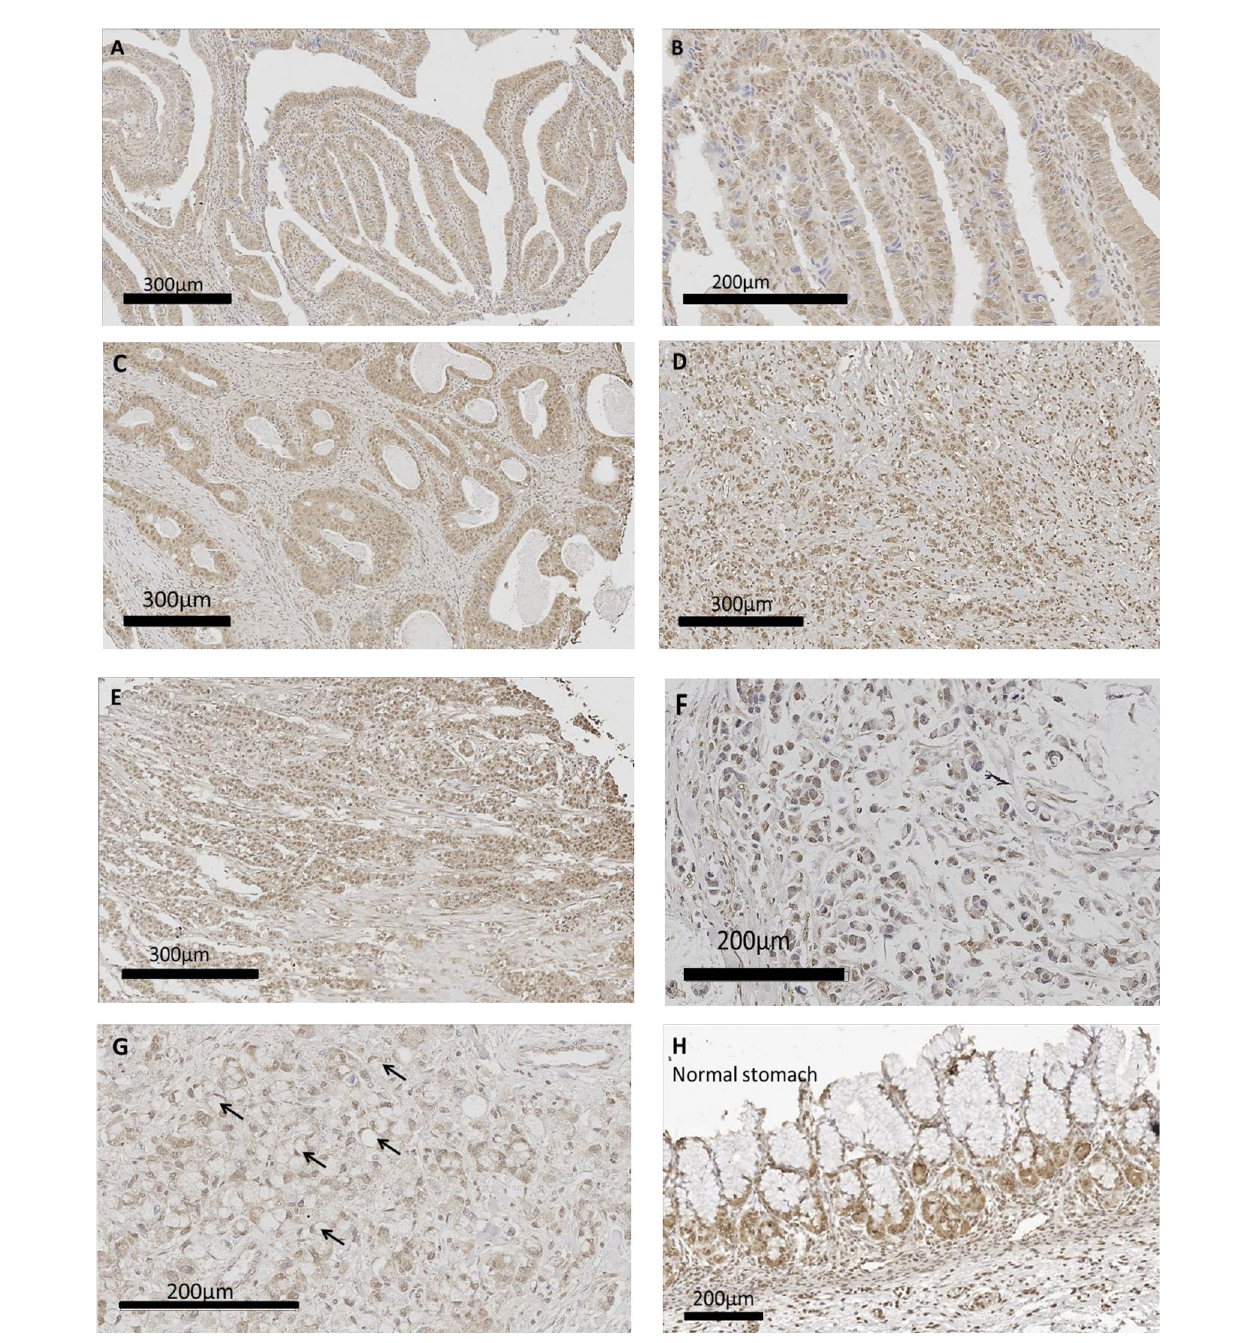
FIGURE 6 | CCK-BR protein expression by immunohistochemistry in human gastric cancer and normal tissues from a human gastric tissue array (US Biomax # BC01011). The array was stained with a CCK-BR antibody (Abcam 77077) at a titer of 1:200 overnight at 4°C. (A – C) Gastric cancer images representative of the intestinal type histology are shown. (D, E) Representative images of gastric cancers with the diffuse histologic type are shown. (F) Gastric carcinoma mucinous adenocarcinoma. (G) Gastric cancer signet ring histology; arrows point to signet ring cells. (H) Histology normal human